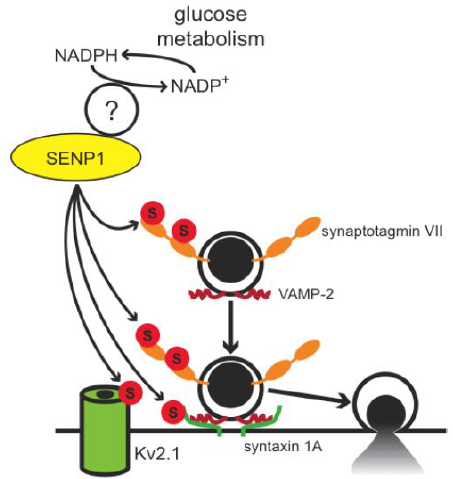
Figure 6. Proposed model for the regulation of insulin exocytosis by deSUMOylation at the exocytotic site. Metabolically derived reducing equivalents, in the form of NADPH, are proposed to amplify insulin exocytosis in part by promoting deSUMOylation of several targets at the exocytotic site. Potential targets include syntaxin 1A, synaptotagmin VII, and the voltage-dependent K + channel Kv2.1. Several questions remain, not the least of which include the molecular mechanism linking NADPH to SENP1